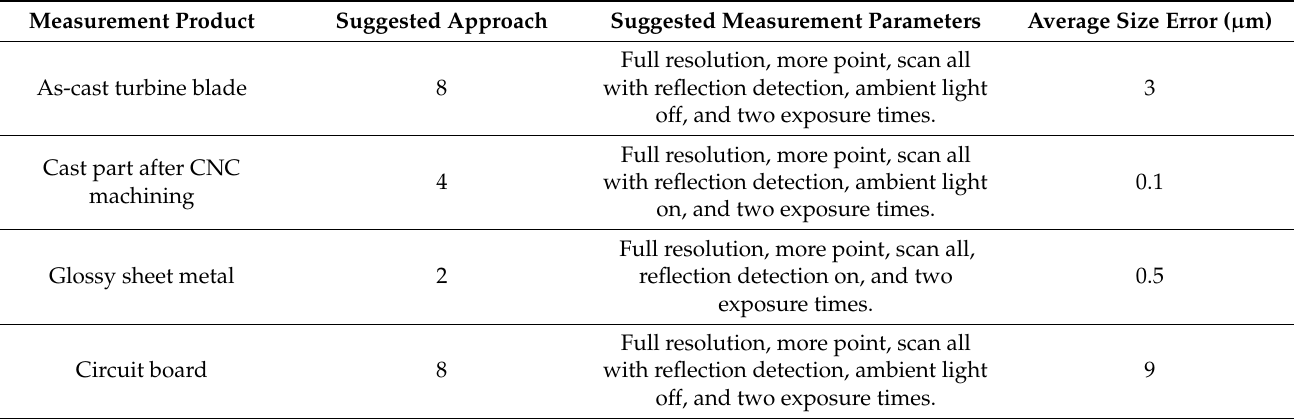
Table 3. An empirical technical database for 3D optical measurement of the object that was not sprayed with a mixture of ethanol and TiO 2